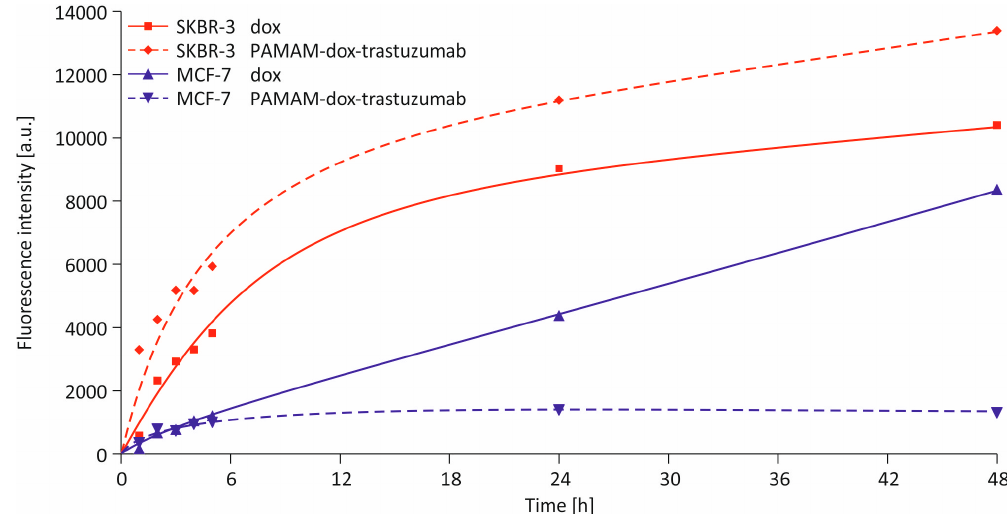
Figure 5. Cellular uptake of free doxorubicin and PAMAM–dox–trastuzumab conjugate at a concentration of 1 µM by MCF-7 (blue triangles) and SKBR-3 (red rhombus/squares) cells after incubation for 1, 2, 3, 4, 5, 24, and 48 h.